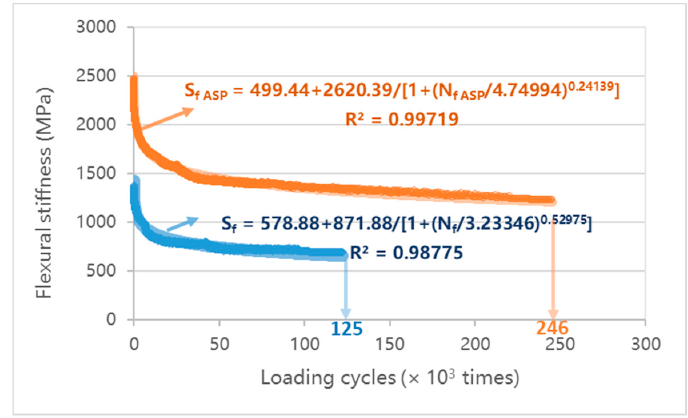
Figure 14. Curve of flexural stiffness with the loading times.